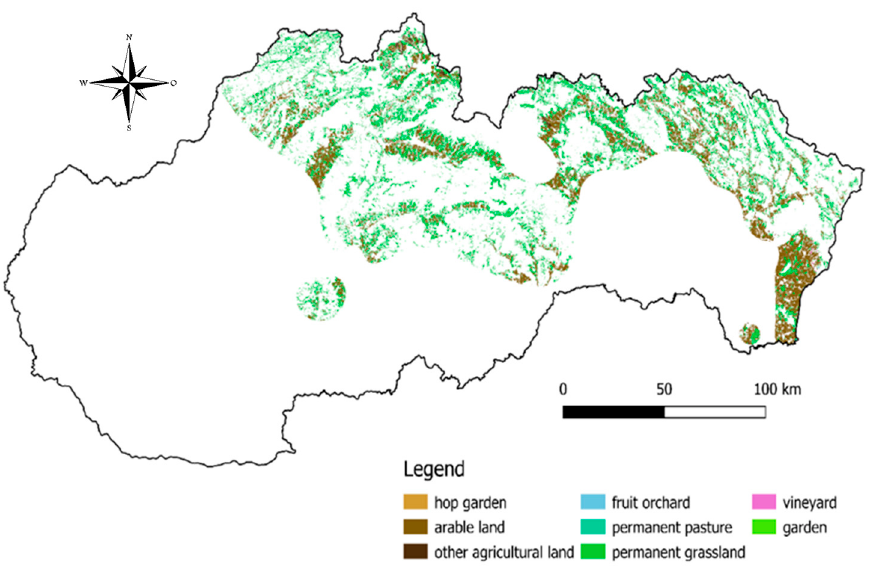
(cid:80) (cid:80) P / ET 0 ≥ 1.